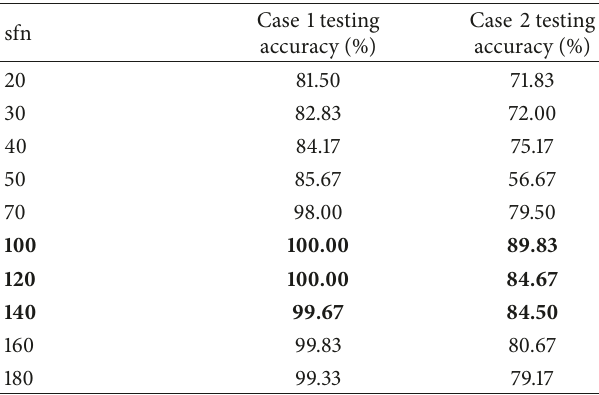
Table 23: Bearing fault diagnosis results obtained by the OFS- FSASD-SNPEL-SVM (dimension size is